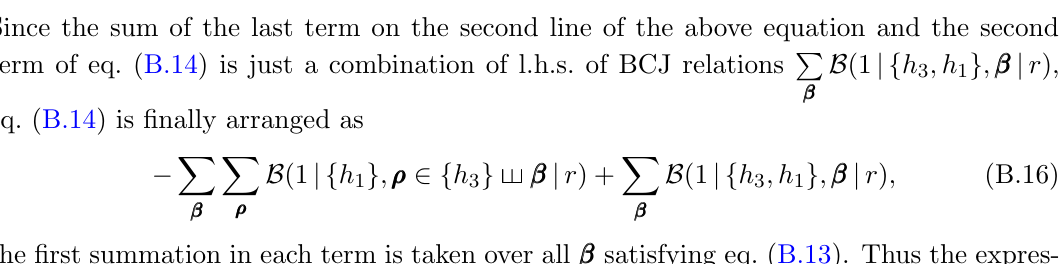
Fig. 28 (c) Table 4 . Total coe(cid:14)cients ( (cid:0) 1) N ( F ) K [ FnF 0 ] for permutations allowed by the graphs in (cid:12)gure